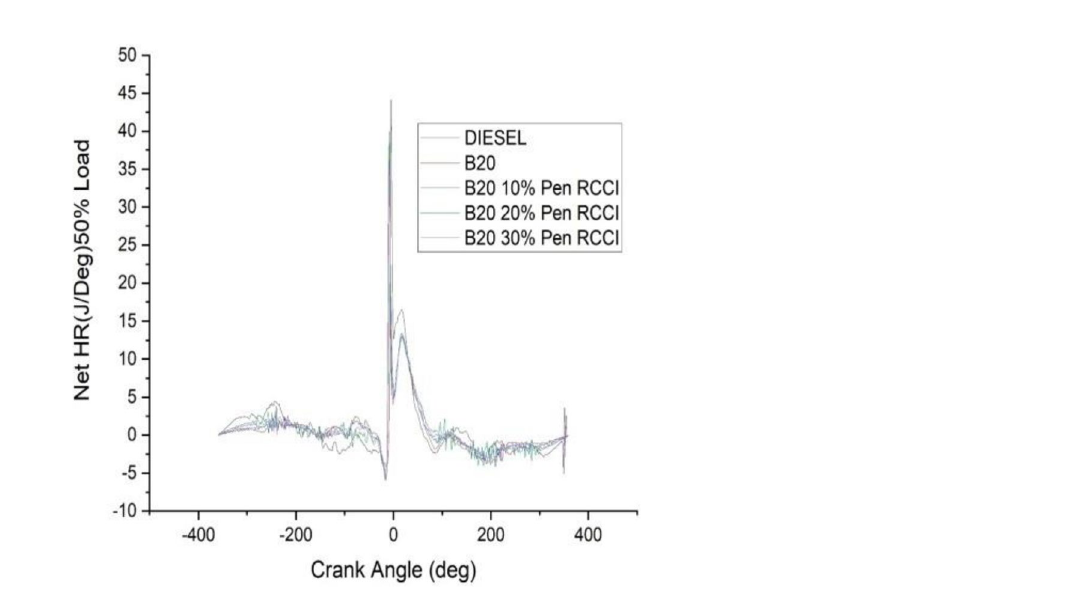
Figure 19. Net heat release at 25% load.